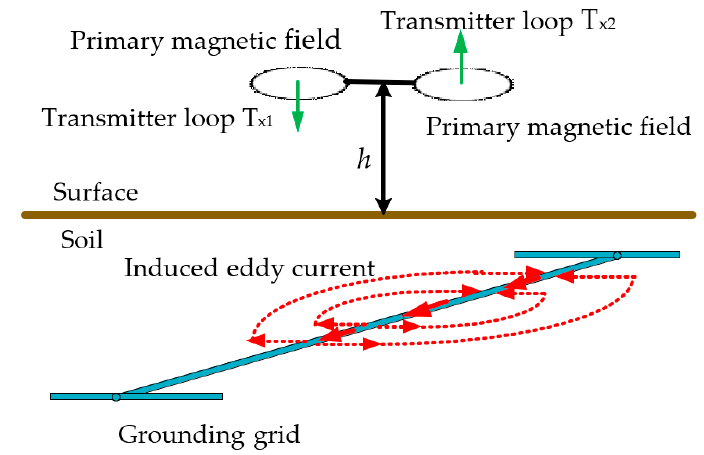
Figure 1. The generation process of magnetic induction.